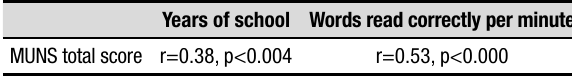
Table 3. Correlations between MUNS total score and years of school and words read correctly per minute.